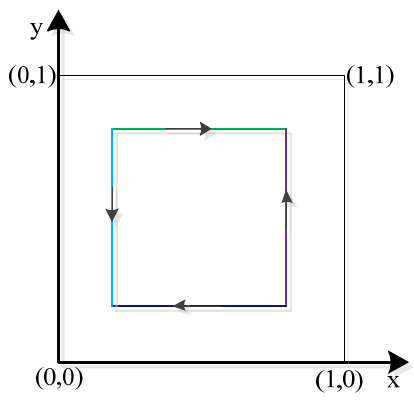
Figure 8. System evolution path of scenario 4.